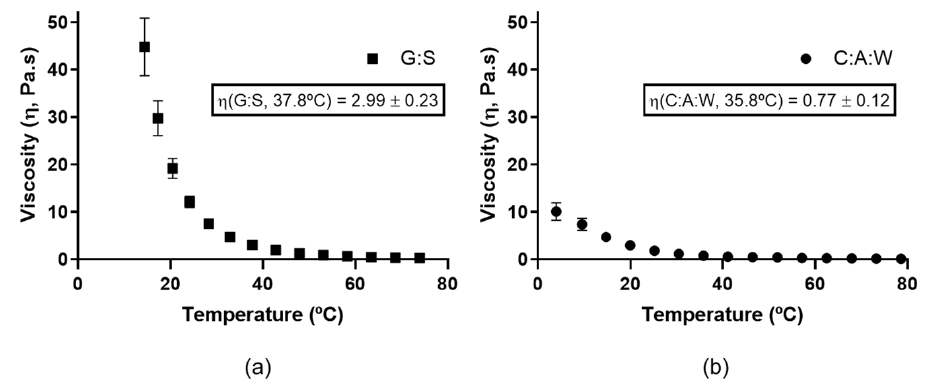
◦ C; ( b ) C:A:W from 4 to 80 ◦